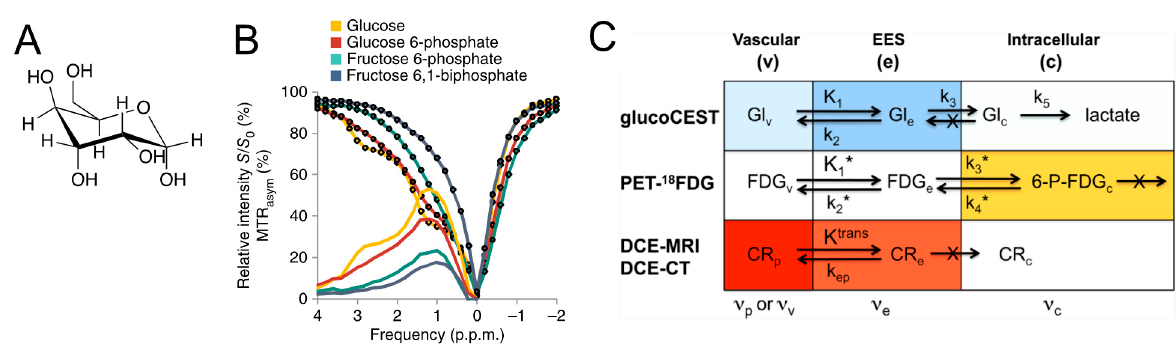
Figure 3. GlucoCEST MRI. ( A ) Chemical structure of glucose. ( B ) Z-spectra and MTR asym spectra of glucose and its first-step metabolite glucose 6-phosphate, as compared to that of fructose 6-phosphate and fructose 6,1-biphosphate (Reprinted with permission from Ref [60]). ( C ) Overview of rate constants and contrast contributions (darker color = higher contrast; white is negligible contrast) for glucoCEST, 18 FDG-PET, and contrast-enhanced MRI and CT in tumors. For glucoCEST, the glucose concentrations in vascular space and EES are comparable, but due to lower pH the EES has a higher signal contribution. Intracellular signal is very small to negligible due to rapid glycolysis. In PET, the signal is predominantly due to trapped intracellular phosphorylated FDG. For contrast-enhanced MR and CT, the agents occupy only plasma in blood and while they enter the interstitium, the EES concentration is generally lower than in plasma due to limited K trans . Glucose, on the other hand moves freely into the interstitium and the erythrocytes. v = vascular (plasma + erythrocytes), p = plasma. Reprinted with permission from Ref [61].